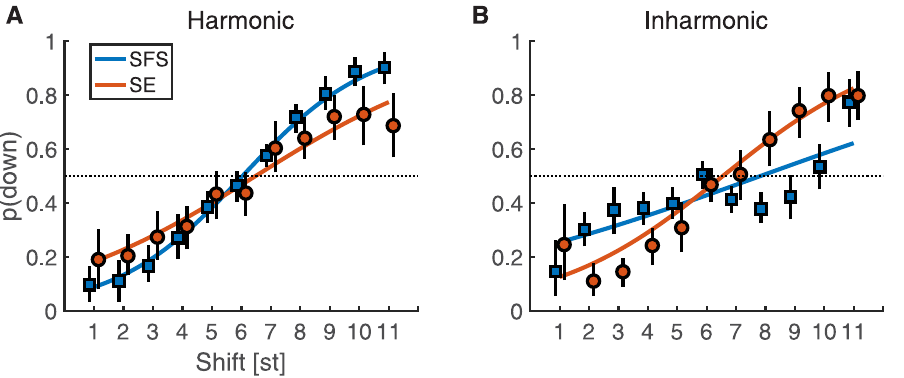
Fig 2. Proportion “down” responses for one-dimensional shifts of Exp. 1 for harmonic (A) and inharmonic (B) Shepard sounds. Colored lines correspond to the fitted GLME model. Black vertical lines indicate 95% confidence intervals across participants obtained by